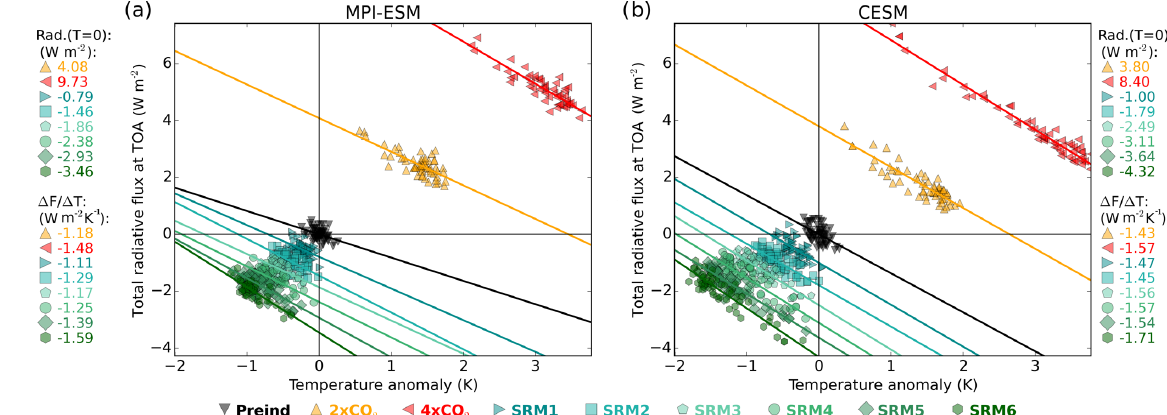
Figure 3. Gregory plots of total all-sky radiative flux change at the top of the atmosphere for (a) MPI-ESM and (b) CESM. Markers indicate a single-year global mean value for one ensemble member, and solid lines are linear fits. Corresponding all-sky radiative forcing – the intersection of the linear fit and the y axes ( T = 0) – in MPI-ESM and CESM is shown at the top, and the slope of the linear fit is at the bottom of the legends next to the panels. Origin represents zero temperature and clear-sky radiative flux anomaly compared to the Preind